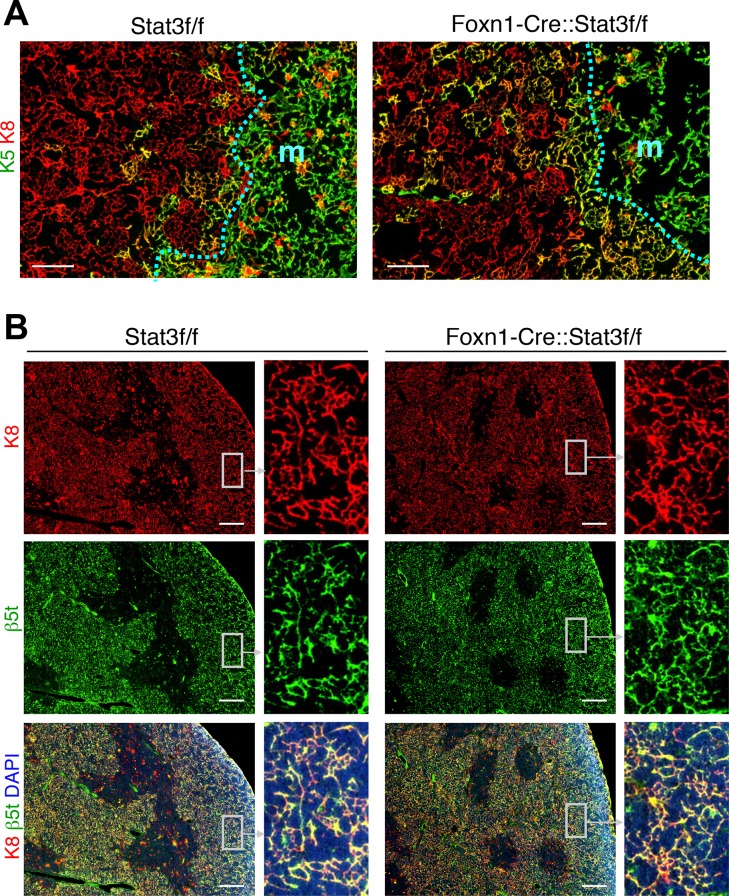
Normal differentiation of cTECs in Foxn1-Stat3-CKO mice.(A) Cryostat sections of the thymus were stained with antibodies directed to K8 (red) and to K5 (green). The dotted blue line indicates the cortico-medullary junction, separating cortex (c) from the medulla (m). Scale bars: 100 μm. (B) Cryostat sections of the thymus were stained with antibodies directed to K8 (red) and to β5t (green). Sections were counterstained with DAPI (blue). Scale bars: 200 μm.